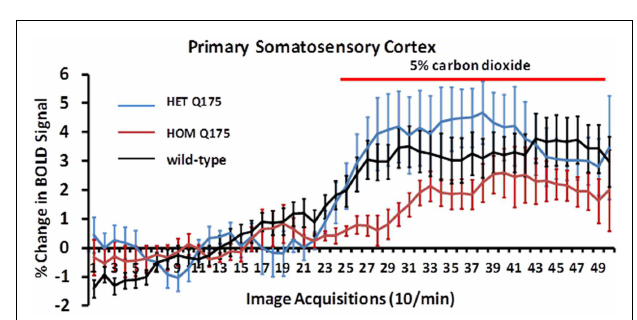
FIGURE 8 | Blood oxygen level dependent signal change to carbon dioxide challenge . Shown are time-course data for each genotype for the percentage change in BOLD signal intensity in the somatosensory cortex in response to the challenge of 5% carbon dioxide. Each image acquisition is the mean ±